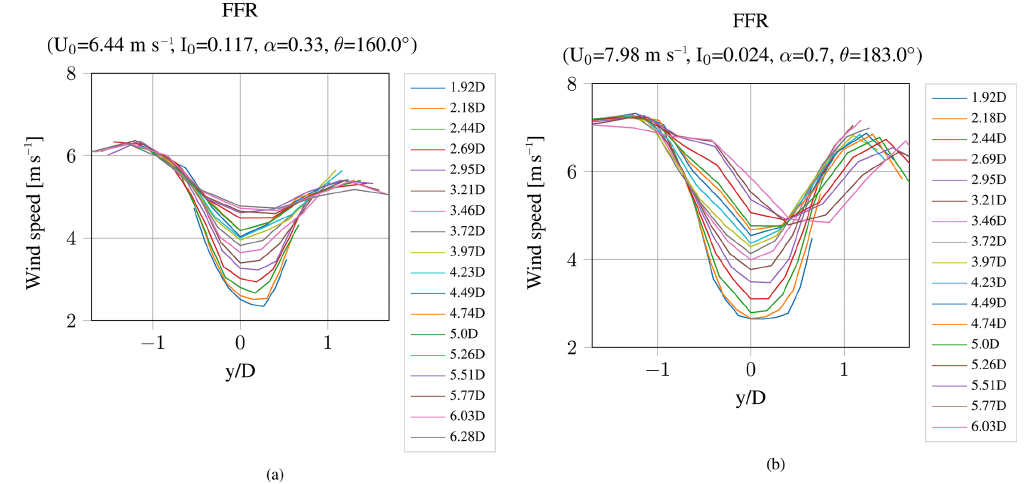
Figure 10. Wind speed deficit in the FFR for a turbulence intensity of 11.7% (a) and a turbulence intensity of 2.4% (b) .